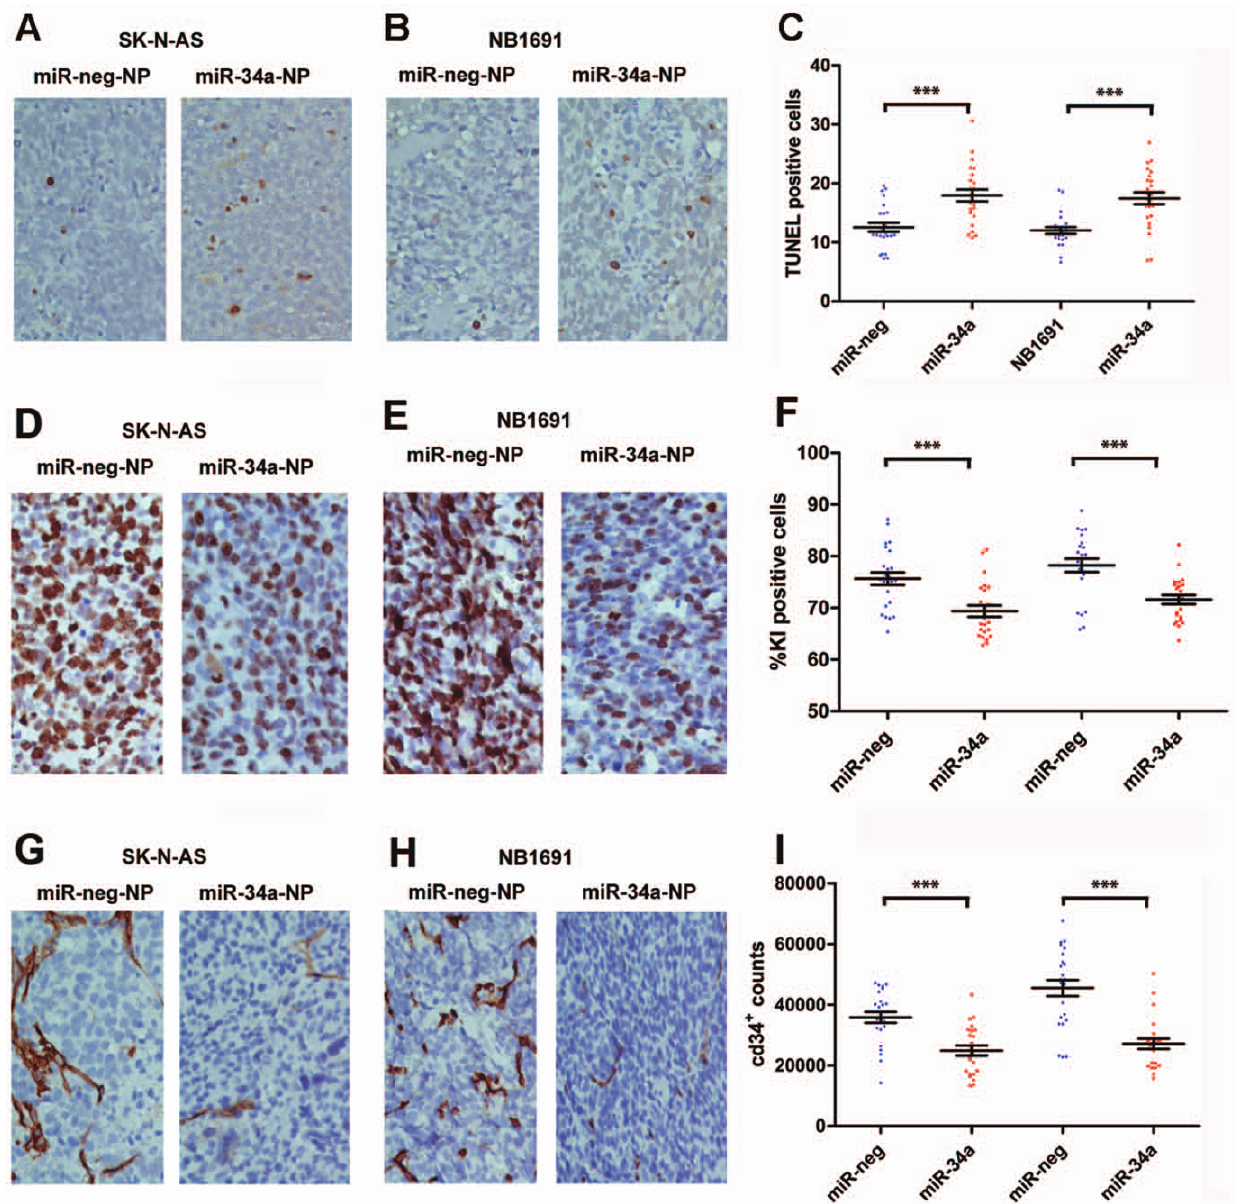
Figure 5. Pro-apoptotic and anti-angiogenic activity of GD 2 targeted nanoparticles containing miR-34a. Tumors of mice treated with anti-GD 2 -miR-34a-NPs and negative controls were analyzed by TUNEL staining on paraffin embedded section of SK-N-AS luc (a) and NB1691 luc (b) tumors. In both tumor subtypes, treatment with anti-GD 2 -miR34a-NPs led to a significant increase in apoptosis ( c , ***p , 0.001, n=8). Immunohistochemistry staining with CD34 showed a marked decrease in the endothelial cell marker subsequent to anti-GD 2 -miR34a-NP treatment (d-f, ***p , 0.001, n=8). KI67 staining showed reduced proliferation in anti-GD 2 -miR34a-NP treated cohorts (g-i , ***p , 0.001, n=8).